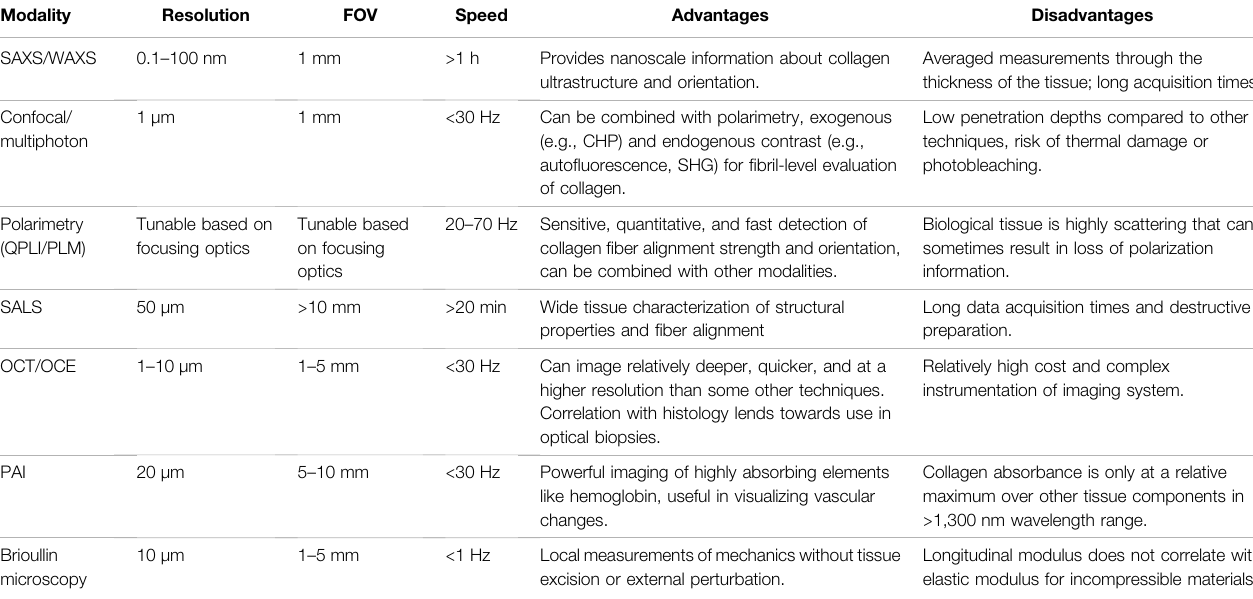
TABLE1| Comparison ofadvantagesanddisadvantagesassociatedwithsomeidenti fi edandcommonlyusedopticalimagingmodalitiesthatareusefulinimagingcollagen